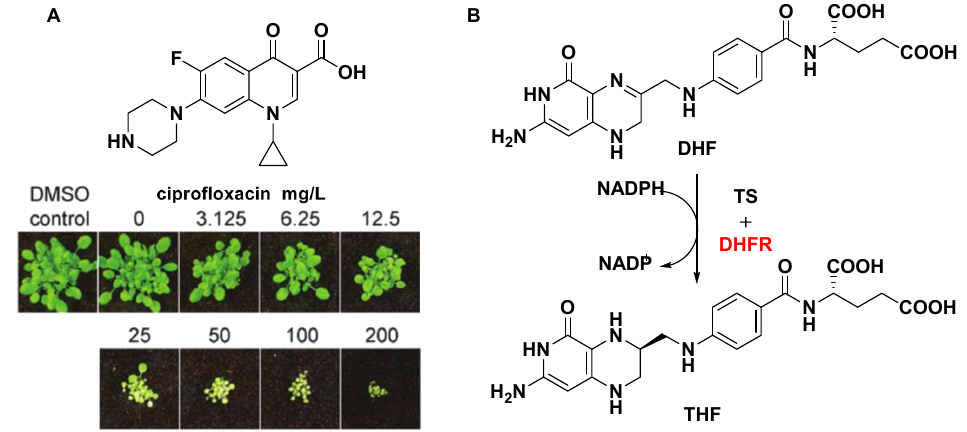
Figure 5. ( A ) Post-emergent herbicidal activity of ciprofloxacin. ( B ) Part of the folate biosynthesis pathway. The potential herbicide target is indicated by the red color.